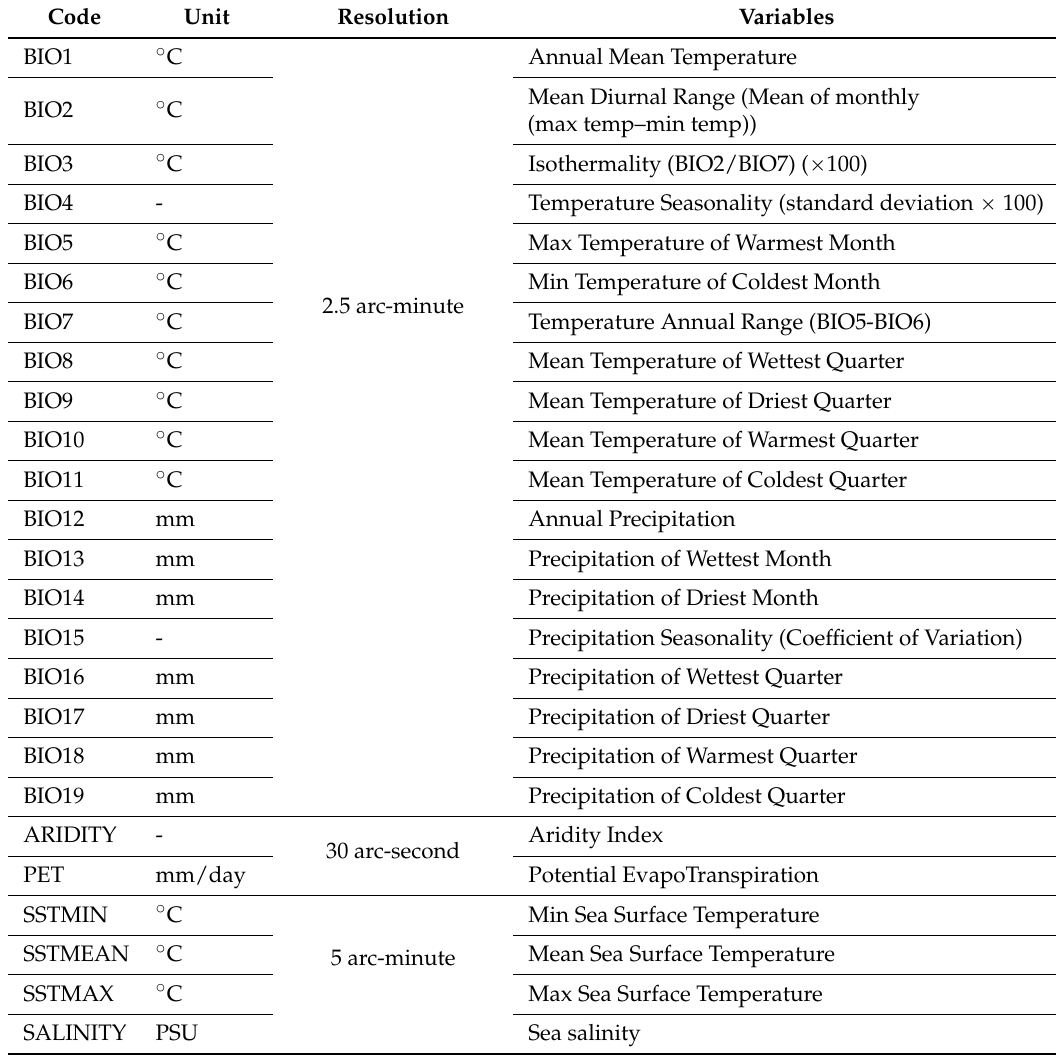
Table 2. List of variables used in this study composed of bioclimatic variables, sea surface temperature and sea